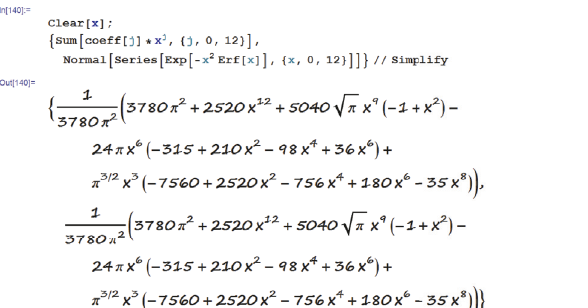
Figure 9: Series expansion of new special function 𝑇(𝑥) around 𝑥 = 0